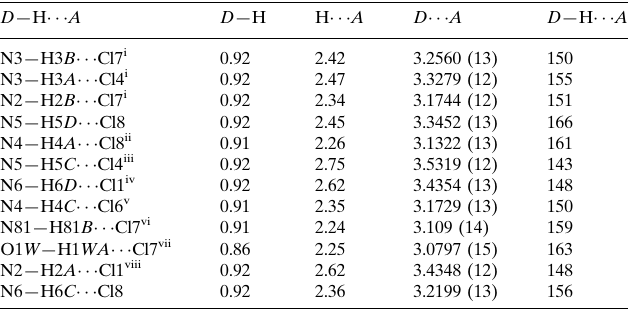
Hydrogen-bond geometry (A˚ , (cid:3)